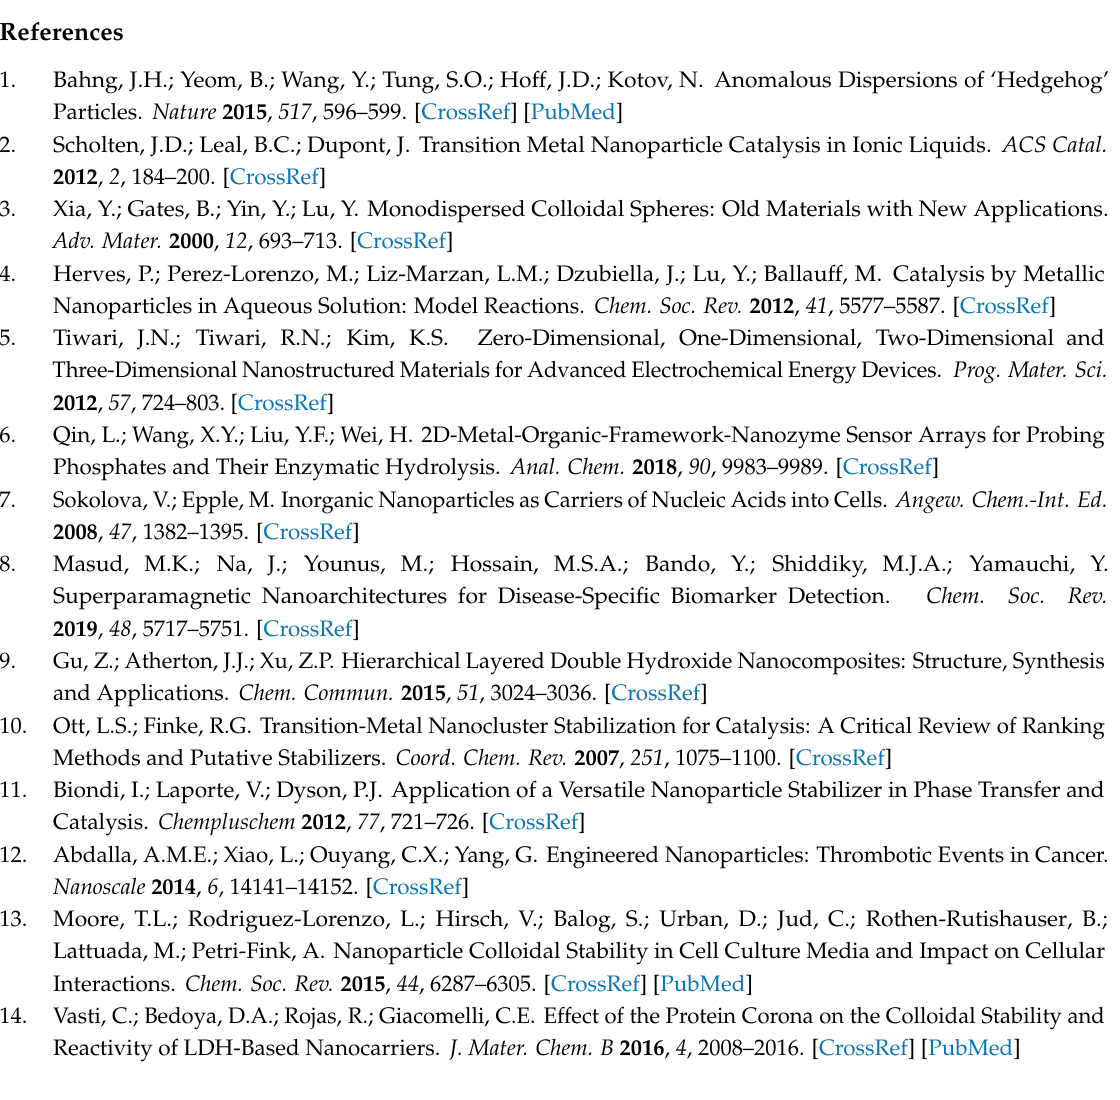
Acronyms used in the table: LDH: layered double hydroxide, TNP: titania nanoparticles, TNS: titania